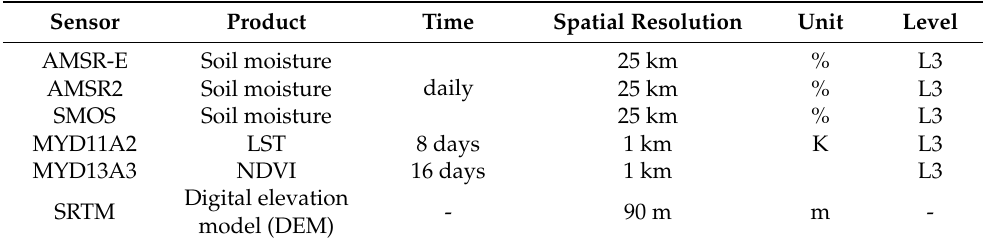
Table 1. Summary of the remote sensing data used in this research.